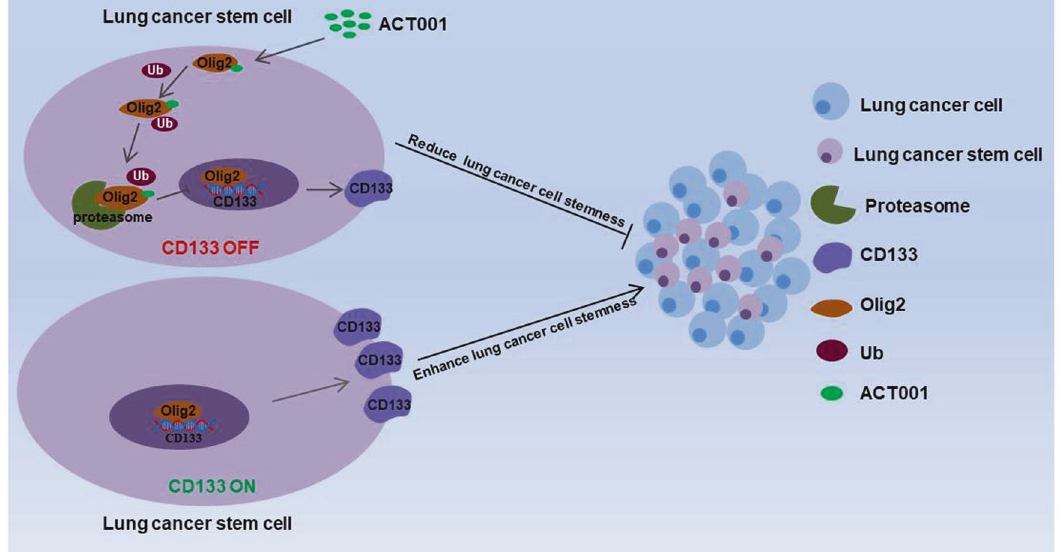
Fig. 7 Schematic diagram summarizing the mechanism. ACT001 directly bound to Olig2 protein and promoted Olig2 degradation via ubiquitin-proteasome pathway and eventually regulated lung cancer stemness marker CD133 transcription in lung